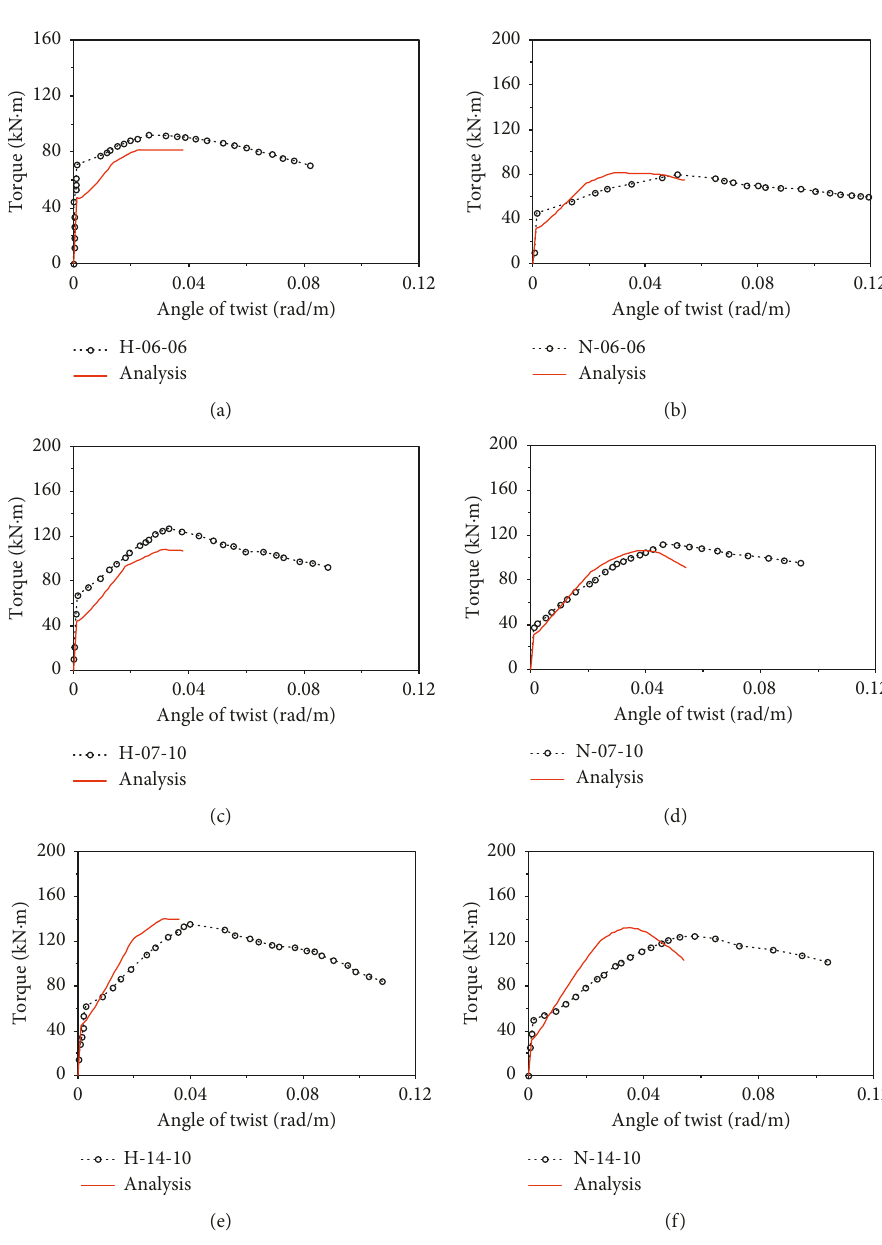
Figure 12: Analysis and test results comparison for beam 1: (a) H-06-06, (b) H-07-10, (c) H-14-10, (d) N-06-06, (e) N-07-10, and (f)